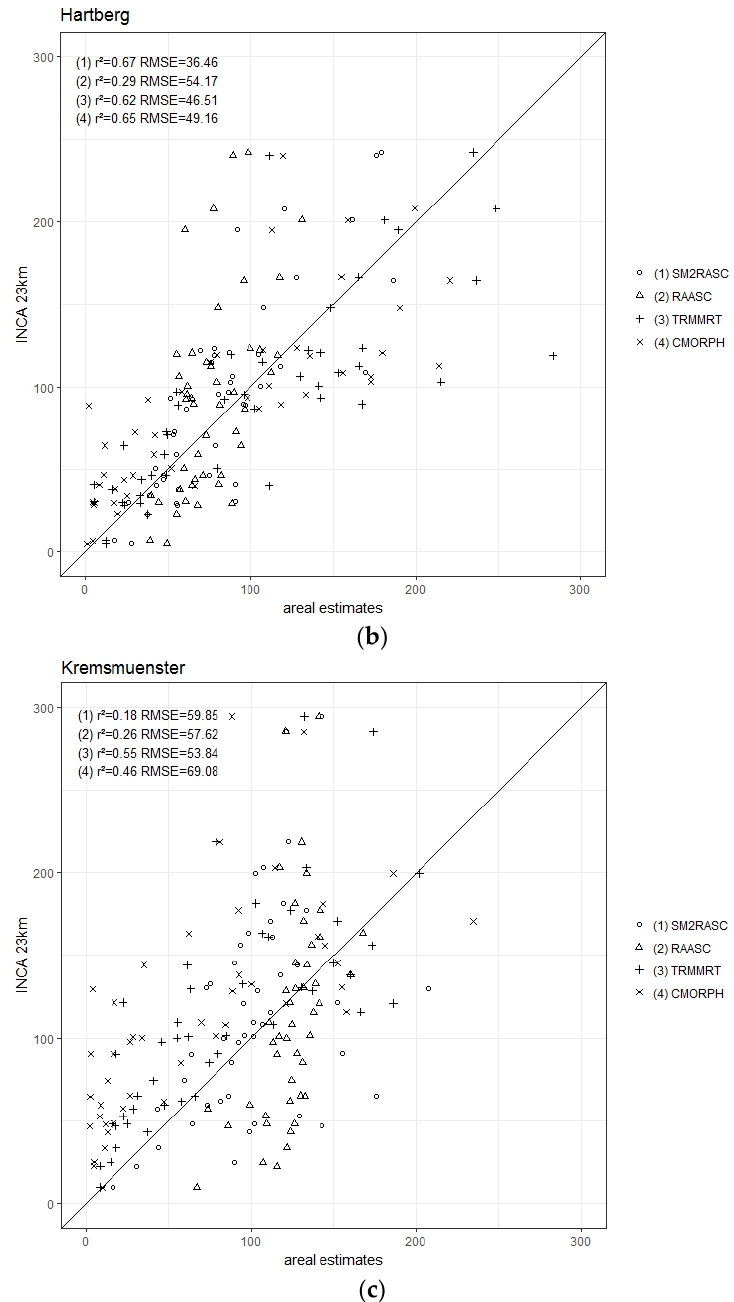
Figure 4. Monthly rainfall differences between INCA 23km and SM2R ASC , RA ASC , TRMMRT and CMORPH, respectively, for the period March until July 2007–2015 in ( a ) Groß-Enzersdorf; ( b ) Hartberg; ( c ) Kremsmünster.